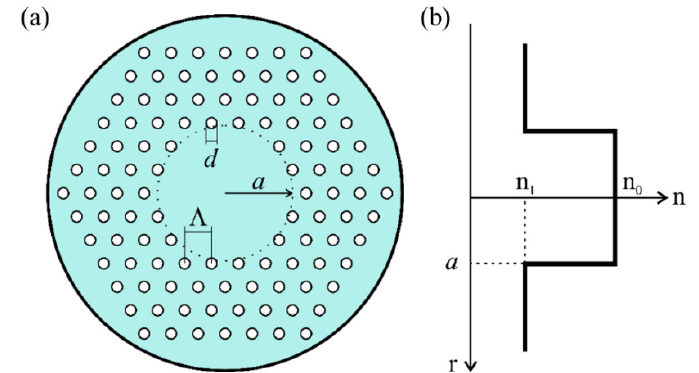
Figure 1. ( a ) Cross section of a multimode SI PPCF ( Λ is the pitch, d is the diameter of air holes in the cladding); ( b ) RI profile of the proposed SI PPCF.